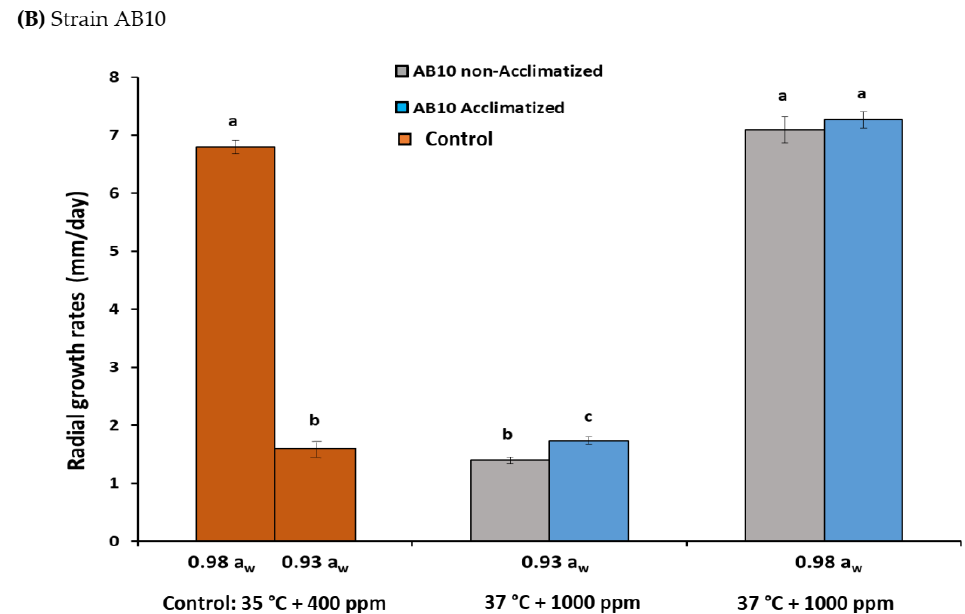
Figure 1. ( A , B ) Comparison of the radial growth rates (mm/day) of non-acclimatised and acclima- tised (for five generations) strains of Aspergillus flavus strains (AB3 and AB10) when colonising layers of raw pistachio nuts incubated in control conditions (35 ◦ C + 400 ppm CO 2 ) and at 37 ◦ C + 1000 ppm CO 2 at 0.98 and 0.93 water activity (a w ). Data are the means of triplicates. Bars represent SEM. Differ- ent letters indicate significant differences between treatments ( p < 0.05) using Fisher’s least significant difference